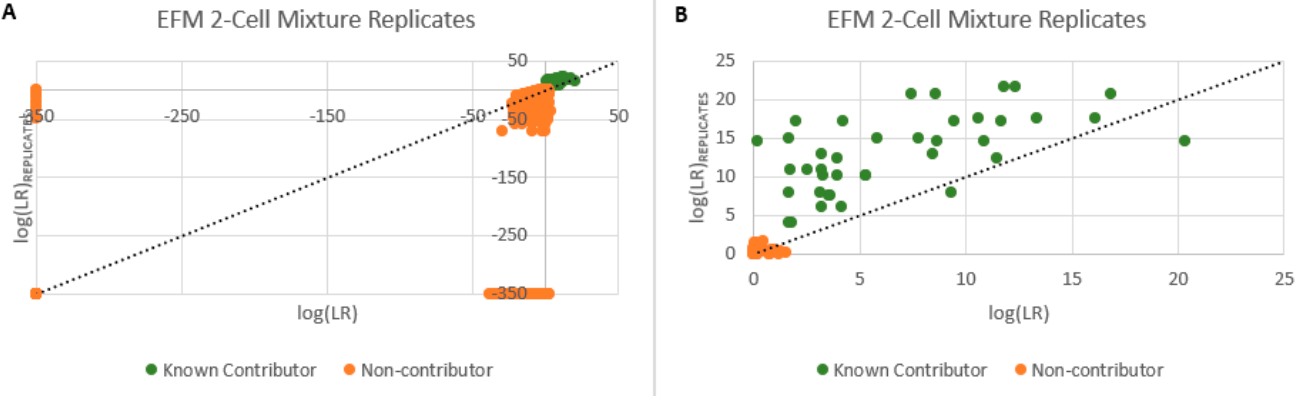
Figure 15. Specificity of DSCS (EFM) mini-mixture analysis. LR = 0 plo tt ed as − 350. Green circles (known contributors), orange circles (non-contributor) ( A ) All samples. ( B ) Detail showing log(LR) > 0 samples. Table 5. Misclassification of single source subsamples for replicate analysis. Correct Profile S3